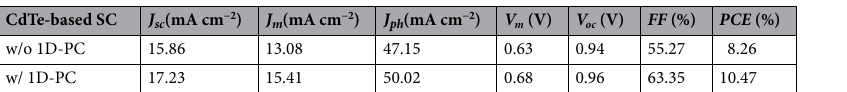
Table 1. Photovoltaic performance parameters of FTO/SnO 2 /CdS/CdTe/MoO 3 and FTO/SnO 2 /CdS/CdTe/ MoO 3 /(MgF 2 /MoO 3 ) 4